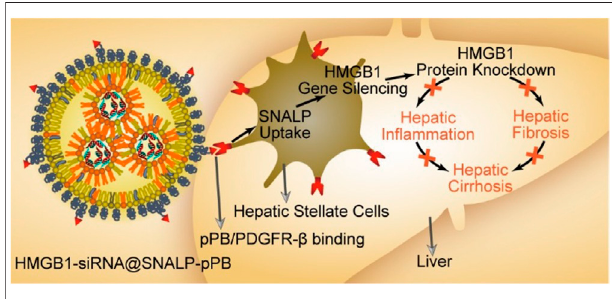
FIGURE 3 | Schematic diagram of the HMGB1-siRNA@SNALP-pPB nanoparticle targeting HSCs to silence HMGB1 to show anti fi brotic and anti- in fl ammatory effects for hepatic cirrhosis (Zhang et al.,